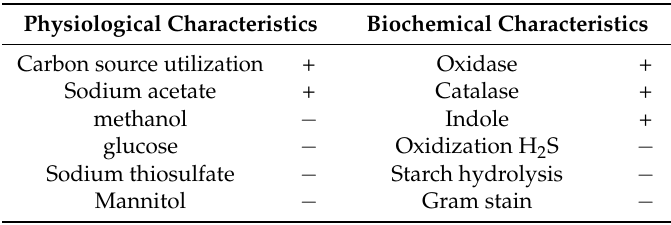
Table 1. The physiological and biochemical characters of Smobiisys501. Physiological Characteristics Biochemical Characteristics